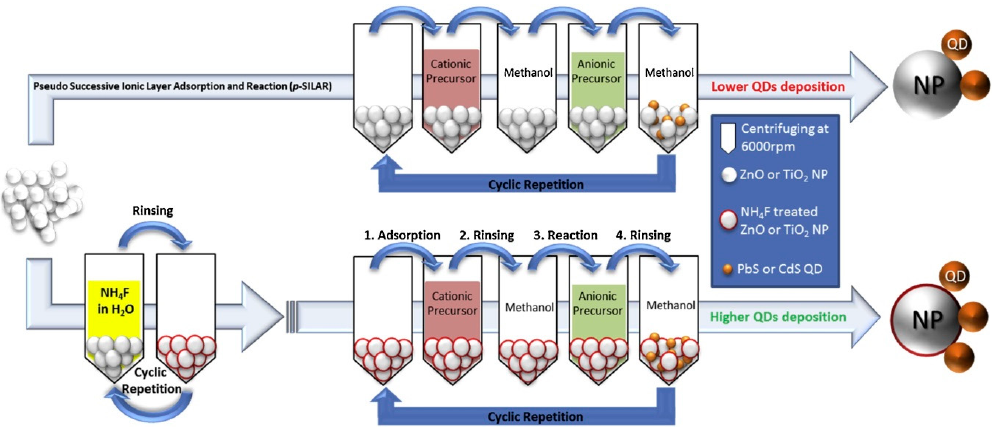
Figure 6. Comparison of the normal (upper row) and the modified p-SILAR process (lower row). From [69], reprinted with permission. Copyright © Elsevier 2016.